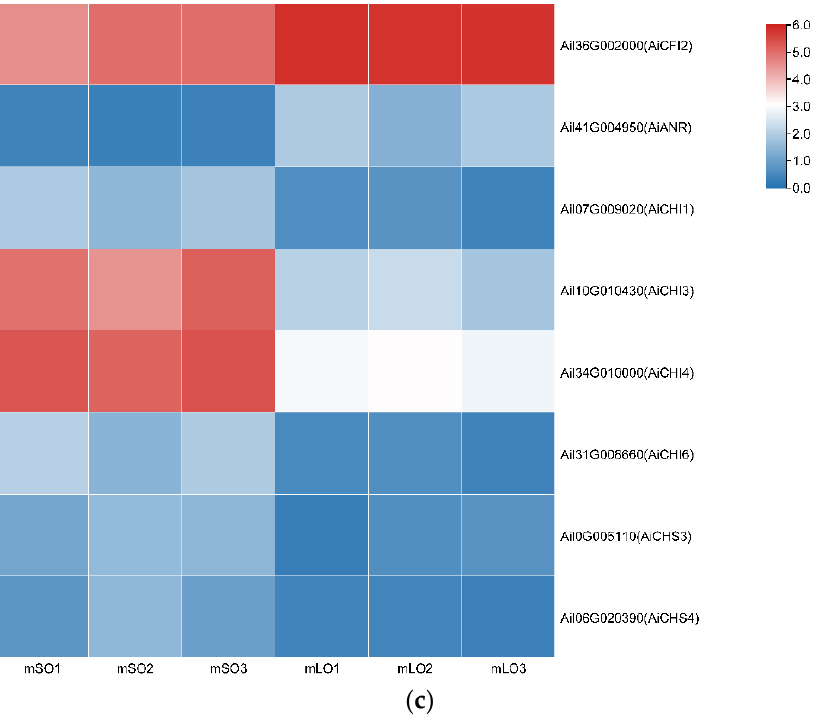
Figure 5. Differentially expressed genes related to flavonoid synthesis in A. ilicifolius parts. ( a ) mRO vs. mLO; ( b ) mRO vs. mSO, ( c ) mSO vs. mOR, mOS, and mOL represent mature roots, mature stems, and mature leaves, respectively. Each part has three biological replicates with the number following the sample name. The differential expression values of genes in the heatmap are treated with log2. Different A. ilicifolius genes and their related genes within the brackets are showed on the vertical axis.